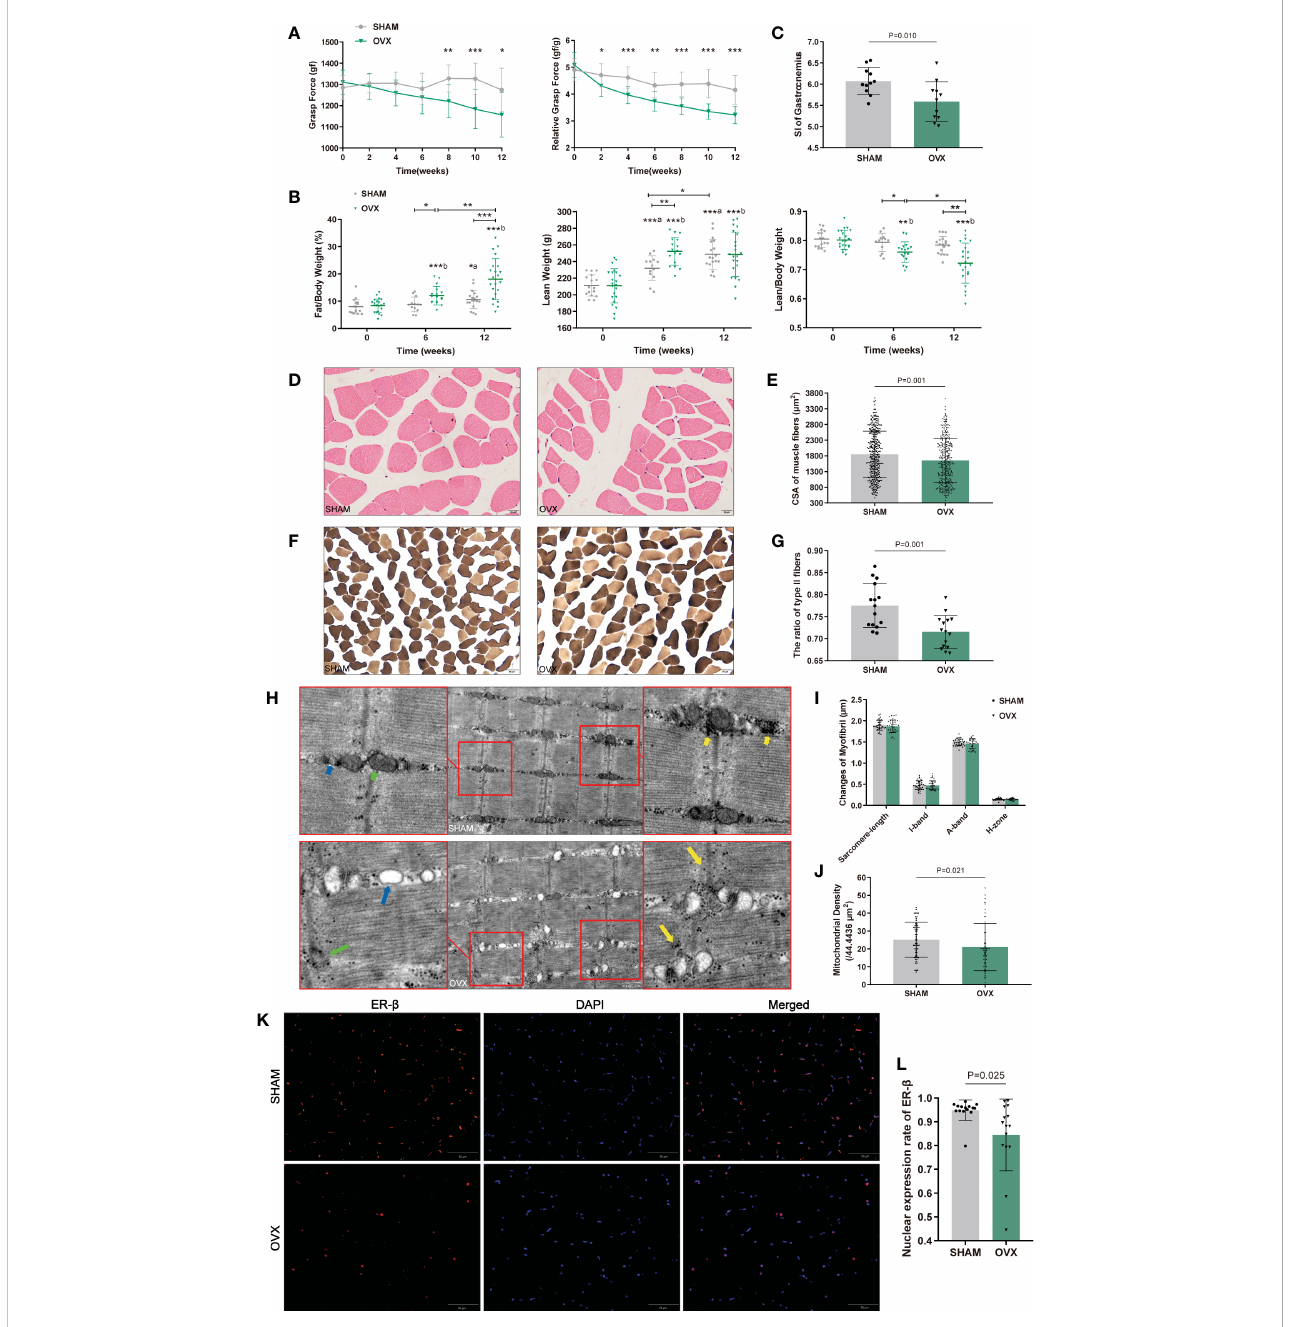
FIGURE 2 Identi fi cation of hormone-related sarcopenia and histological changes in GAS. (A) Forelimb grip force and weight-adjusted grip force. n=12 in each group. (B) Body compositions analysis by DXA. n ≥ 13. (C) Sarcopenia index (SI) of gastrocnemius. n=11. (D) Myo fi bers with H&E staining. n=5. Scale bar, 20 m m. (E) Quantitative analysis of CSA. n=4 (3 random fi elds per sample). (F) Myo fi bers with ATPase staining. n=5. Scale bar, 50 m m. (G) Quantitative analysis of the ratio of type II fi bers. n=5 (3 random fi elds per sample). (H) Ultrastructure of myo fi brils by TEM. n=6. Scale bar, 1 m m. The short green arrow indicates normal mitochondria and the long one indicates abnormal mitochondria; the short blue arrow indicates normal endoplasmic reticulum and the long one indicates swollen endoplasmic reticulum; the short yellow arrows indicate enriched muscular glycogen and the long ones indicate dispersed muscular glycogen. (I) Quantitative analysis of myo fi brils. n=6 (3 random fi elds per sample). (J) Mitochondrial counts within the unit area. n=6 (10 random fi elds per sample). (K, L) The nuclear expression of ER- b . n=5 (3 random fi elds per sample). Scale bar, 50 m m. Data are performed as mean ± SD. The statistical signi fi cance is expressed as * P <0.05, ** P <0.01, *** P <0.001. ‘ a ’ and ‘ b ’ represent the comparison with SHAM-0 and OVX-0 (before modeling)